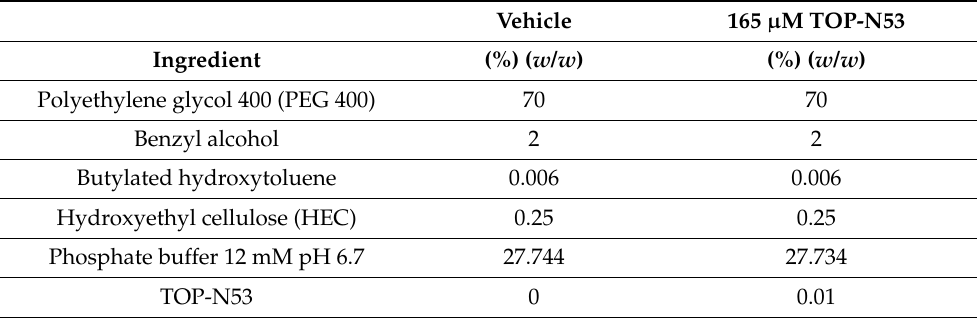
Table 1. Composition of liquid hydrogel formulations: Vehicle and TOP-N53, 165 µ M. Vehicle 165 µ M TOP-N53 Ingredient (%) ( w / w ) (%) ( w / w ) Polyethylene glycol 400 (PEG 400) 70 70 Benzyl alcohol 2 2 Butylated hydroxytoluene 0.006 0.006 Hydroxyethyl cellulose (HEC) 0.25 0.25 Phosphate buffer 12 mM pH 6.7 27.744 27.734 TOP-N53 0